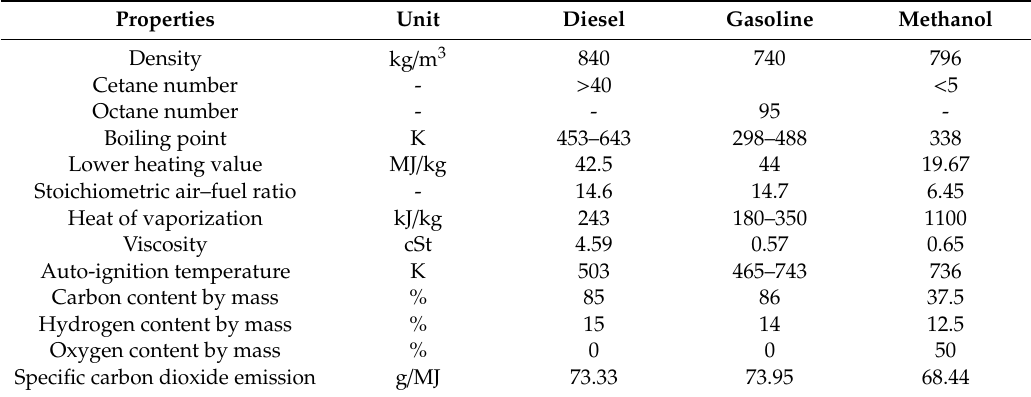
Table 1. Physical and chemical properties of selected